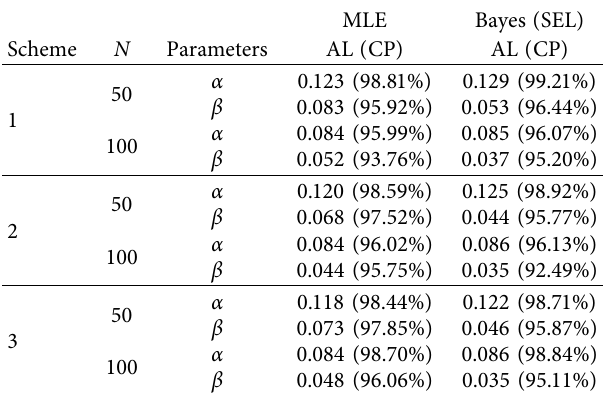
Table 4: Average lengths and coverage percentages for 95% asymptotic and credible CI based on PT2CS, with α � 1 . 5 and β � 0 .